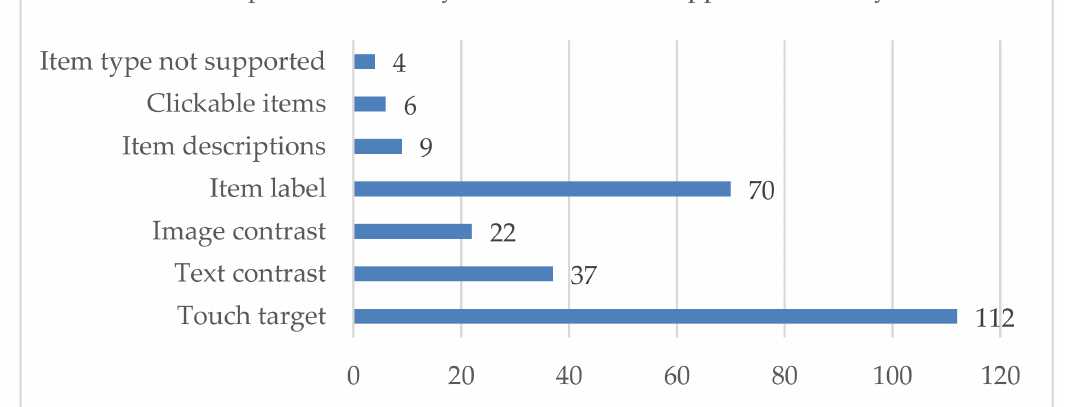
Figure 12. Most frequent errors in the analyzed sample. Source: own elaboration from Google ´ s Accessibility Scanner